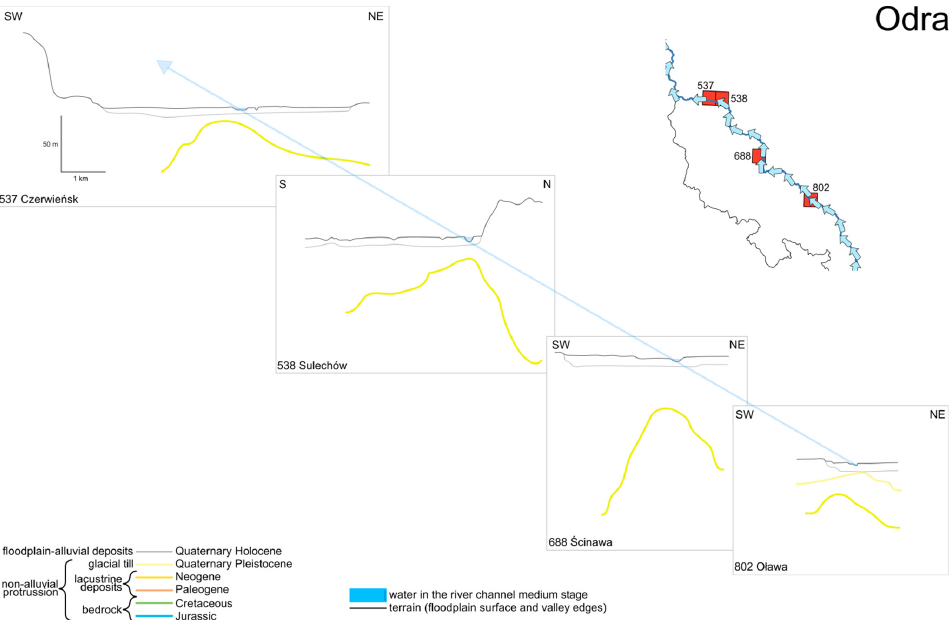
Figure 3. Geological cross-sections through the Narew river valley, according to [52–54]. Each cross-section presents on: water in the river channel during medium stage (blue body); schematic river channel with flow direction (blue line) the valley profile graph with the floodplain surface and the valley’s walls (black), alluvial cover of the floodplain (grey) and non-alluvial protrusion underneath. The color of the non-alluvial protrusion indicates its age according to the stratigraphic chart [43].